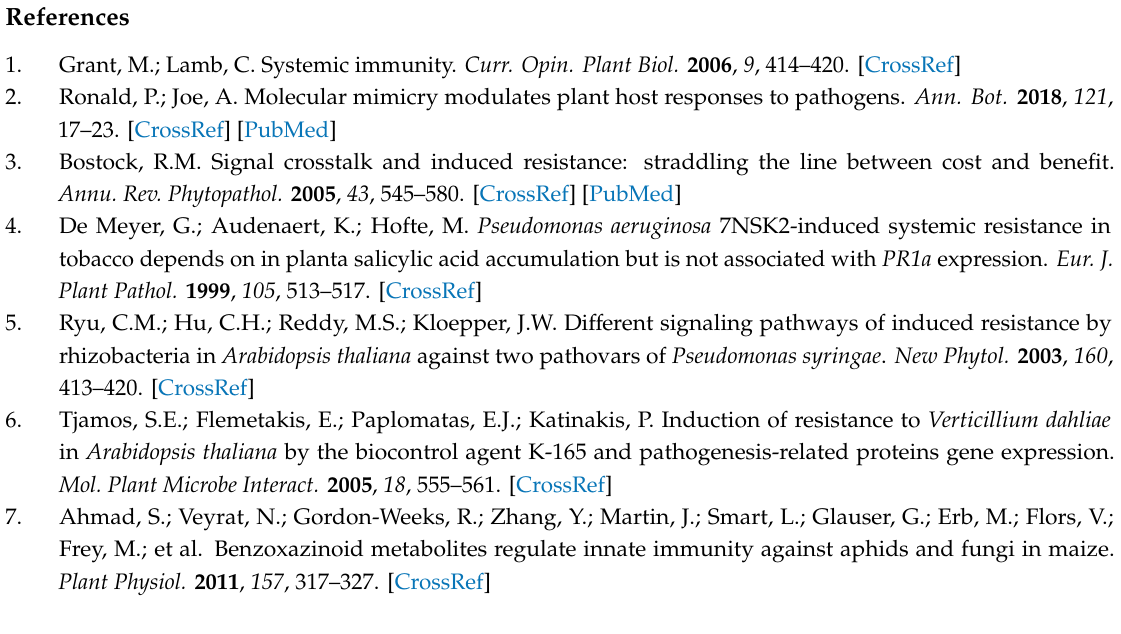
Table S1: Primers used in this study. Table S2: Up-regulated and down-regulated genes di ff erentially expressed in the P. fluorescens MZ05-inoculated plants compared with the non-inoculated plants. Figure S1: Comparative analyses of total lesion area between the susceptible (Anke35) and resistant (Anke78) maize inbred lines. Four-week-old maize seedlings were treated with S. turcica at 5 × 10 4 conidia mL − 1 for 5 d. Total lesion area was measured on the fourth leaves from individual plants using ImageJ software. Statistical analyses for the data were conducted from three independent experiments and each experiment consisted of 15 plants. Asterisk indicates significant di ff erence between the two maize inbred lines using Student’s t-test at p < 0.05. Figure S2: qPCR analyses of eight randomly selected genes among all the